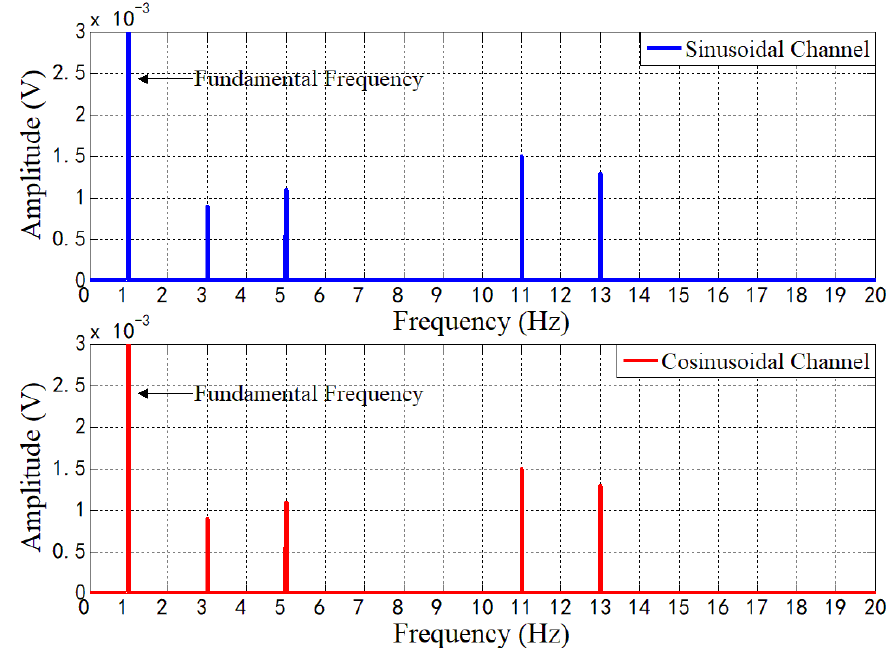
Figure 5. Spectrum of resolver signals at fixed speed in simulation.